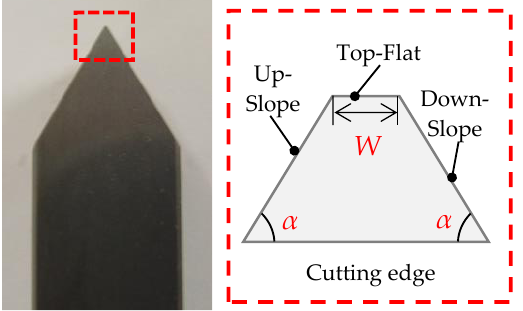
Figure 8. Schematic of a cutting tool.